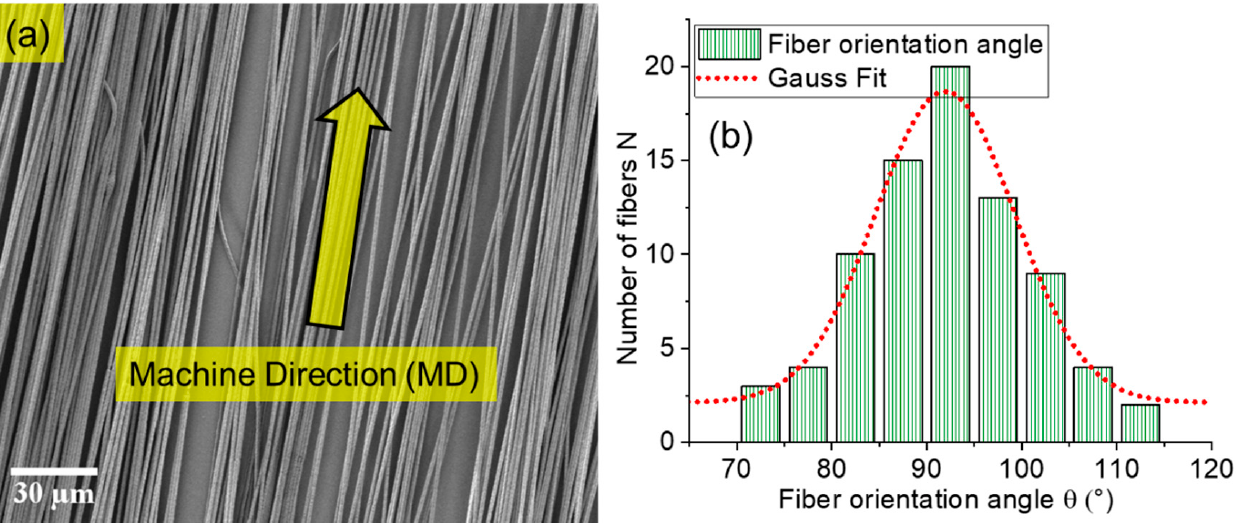
Figure 1. Panel ( a ) shows SEM image with high orientation of electrospun fibers. Panel ( b ) shows directionality analysis with the histogram and normal distribution curve (Gauss Fit) of orientation angle. The class width is approximately 5°. 90° is positioned in the middle of the class because the fibers were aligned to the machine direction MD.